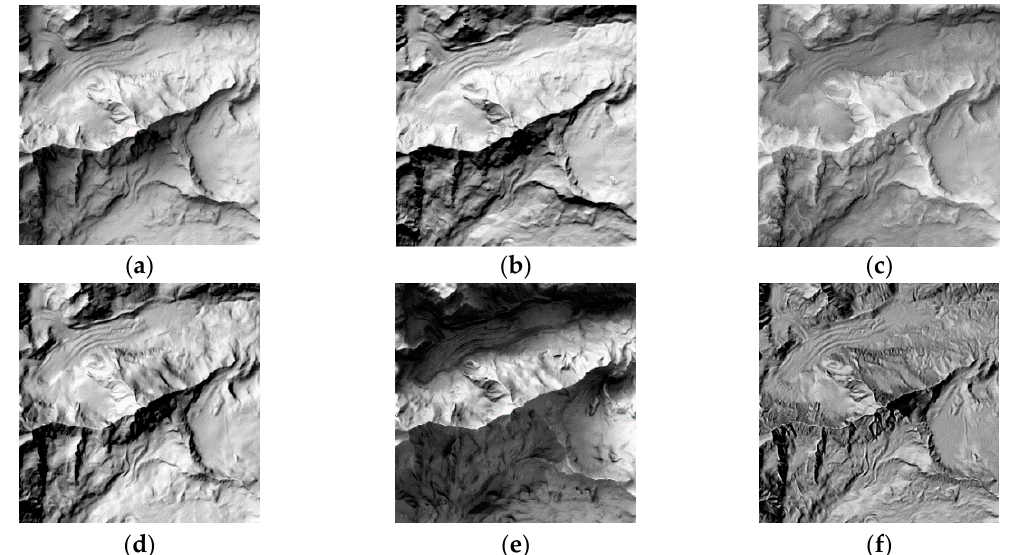
Figure 6. Methods chosen to portray block mountains: ( a ) clear sky model; ( b ) hillshading with NNW